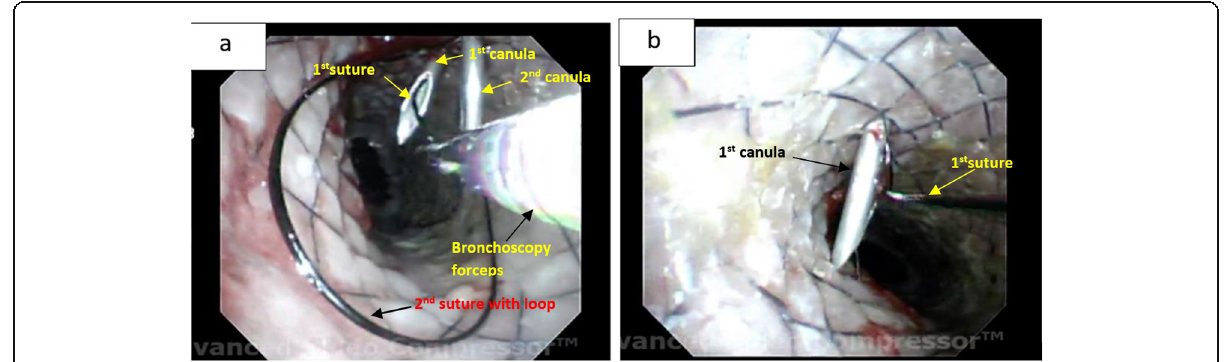
Fig. 4 Bronchoscopic image of double hitch stitch procedure